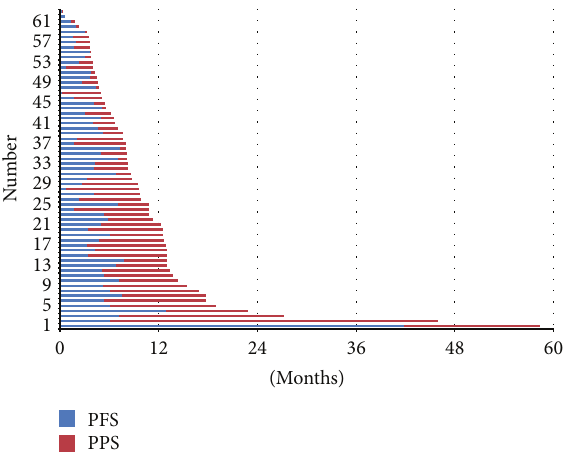
Figure 3: Progression-free survival (PFS) and postprogression survival (PPS) in the overall